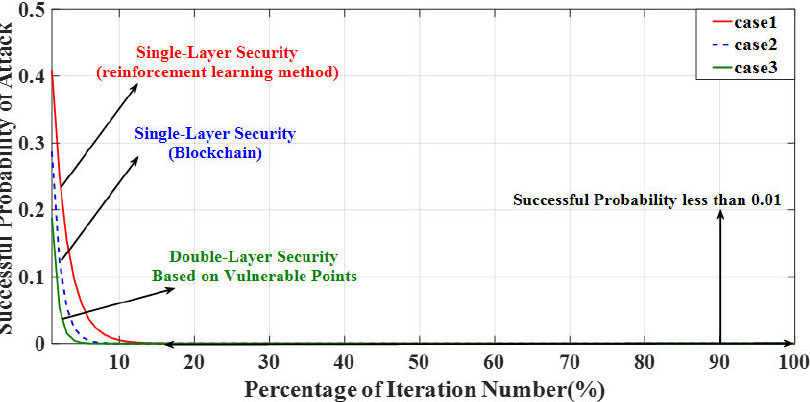
Figure 15. Assessing the successful probability of attack for different cases.